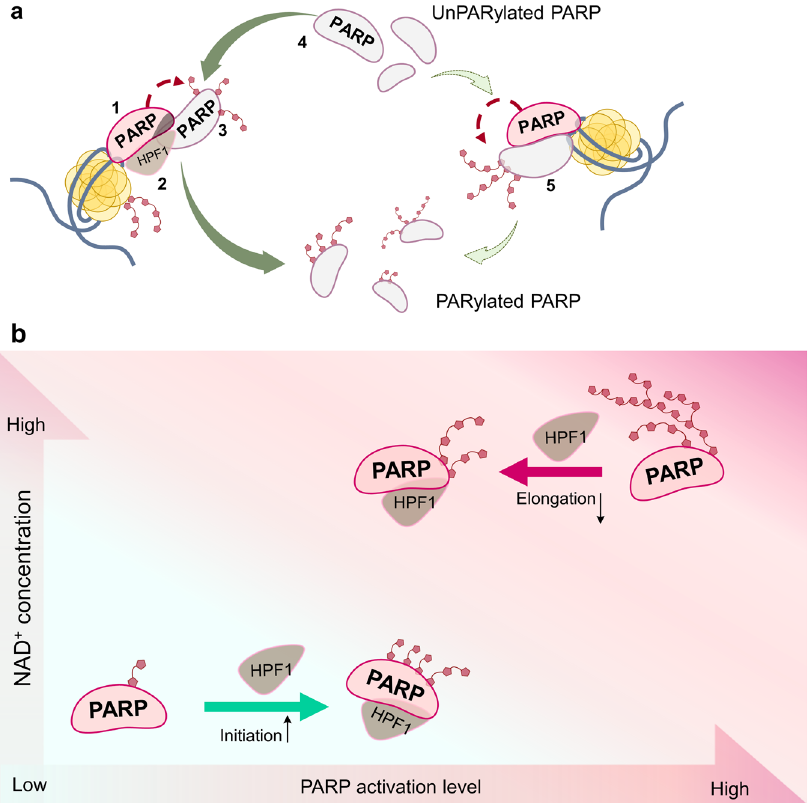
Fig. 7 Proposed mechanisms of PARP activity regulation by HPF1. a The HPF1-free PARP molecules serve as available PAR acceptors; their exchange with the PARylated PARP in the complex with HPF1 leads to increase in the PARylation reaction turnover. b The HPF1-produced effects on PARP activity depend on the NAD + concentration: stimulation is predominant function at low NAD + concentrations, while the hyperactivation at high concentrations of the substrate is